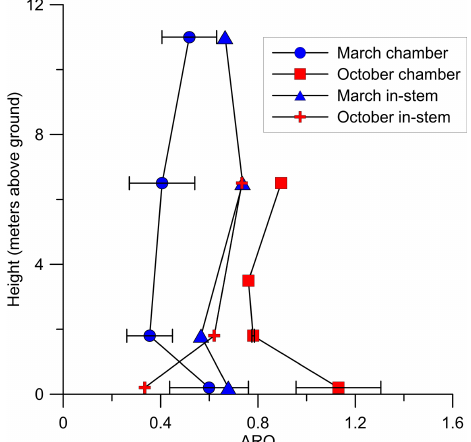
Figure 7. Instantaneous ARQ (ratio of CO 2 efflux / O 2 influx for tree stems) measured from stem chambers installed at different heights above the ground on a S. micranthum tree in Brazil. At the same heights ARQ was measured from 4cm in-stem probes. The measurements were conducted during 30 March and 18 Octo- ber 2012. Error bars represents SD of duplicate samples from the same stem chamber.